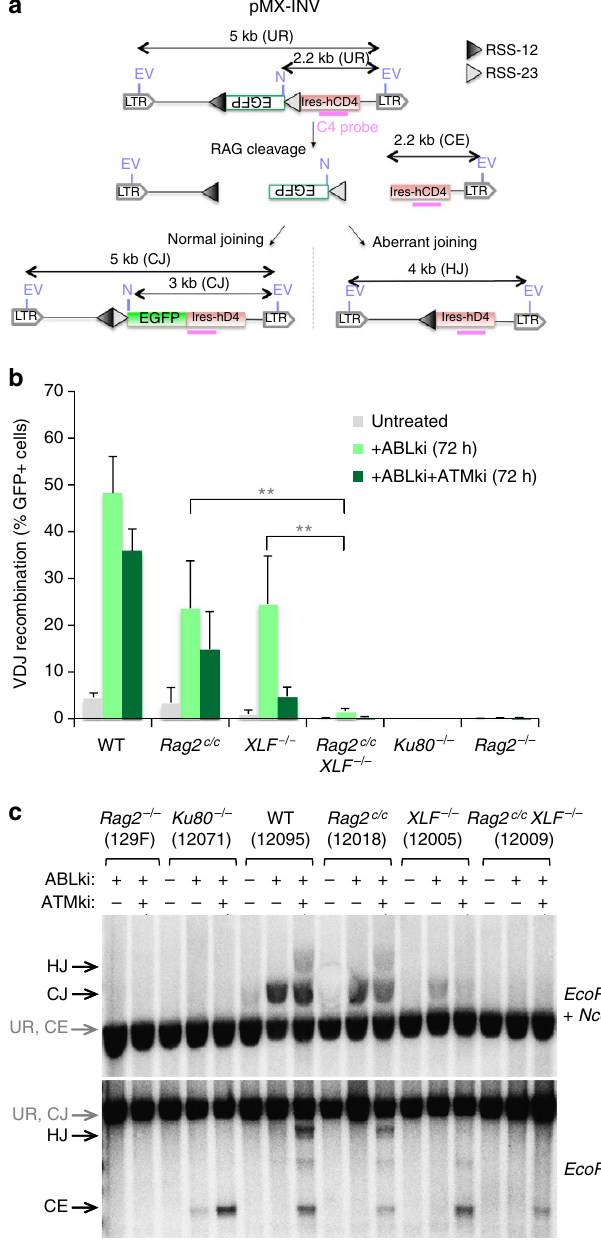
Experiments were repeated three times for ABLki-treated cells and performed once for ABLki/ATMki-treated cell lines. ** P o 0.005. ( c ) The indicated v-abl pro-B cell lines containing the pMX-INV substrate were treated for 72h with ABLki with or without ATMki and assayed by Southern blotting; EcoRV/NcoI digest—C4 probe (top panel) and EcoRV digest—C4 probe (bottom panel). The data presented are representative of at least two experiments using independent cell lines (see also Supplementary Fig.